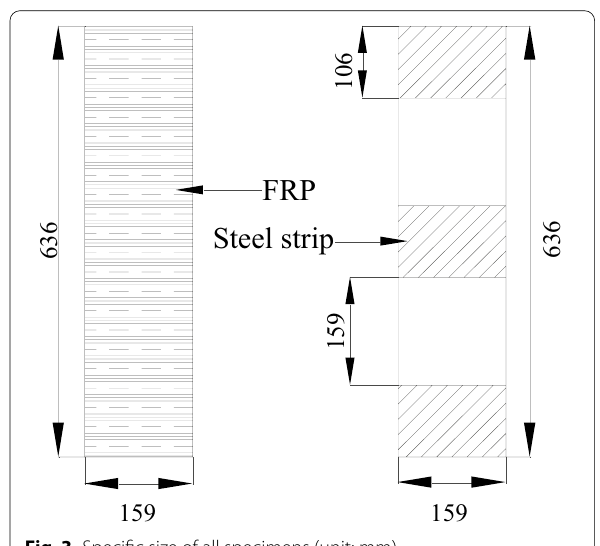
Fig. 3 Specific size of all specimens (unit: mm)